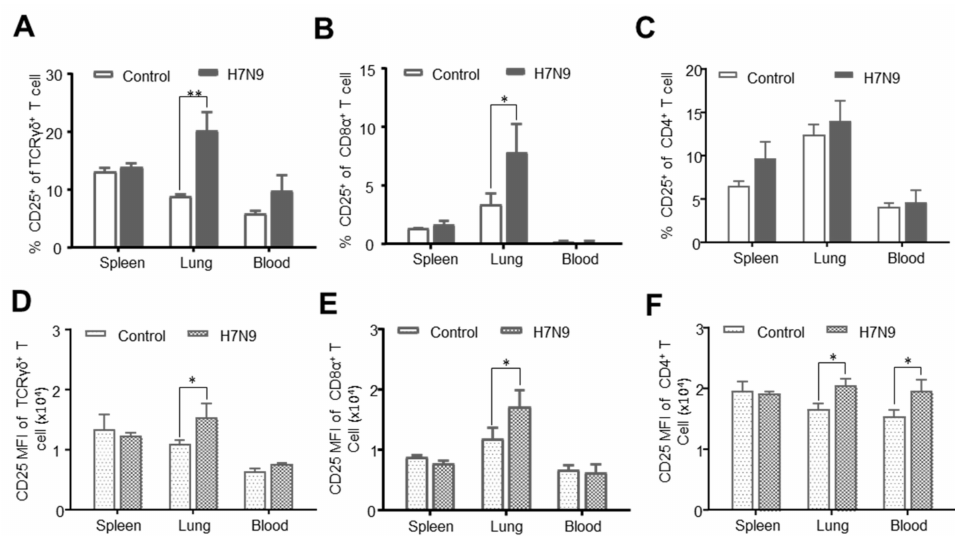
Figure 6. CD25 expression of chicken T cell subtypes after H7N9 infection. Single cells were isolated from the spleen, lung, and blood of non-infected (Control) and H7N9-infected (H7N9) chickens at 14 dpi and stained with antibodies from panel 2. CD25 expression on T-cell subsets was analyzed by flow cytometry. The percentages of TCR γδ + CD25 + T cells ( A ), CD8 + CD25 + T cells ( B ), and CD4 + CD25 + T cells ( C ) in the spleen, lung, and blood were compared between the two groups. The mean fluorescence intensity (MFI) of CD25 expression on single γδ T cells ( D ), CD8 + T cells ( E ), and CD4 + T cells ( F ) from non-infected and H7N9 infected chickens were compared. The data are representative of six di ff erent infected and non-infected birds. The mean ± SD value are shown (* p < 0.05, ** p <